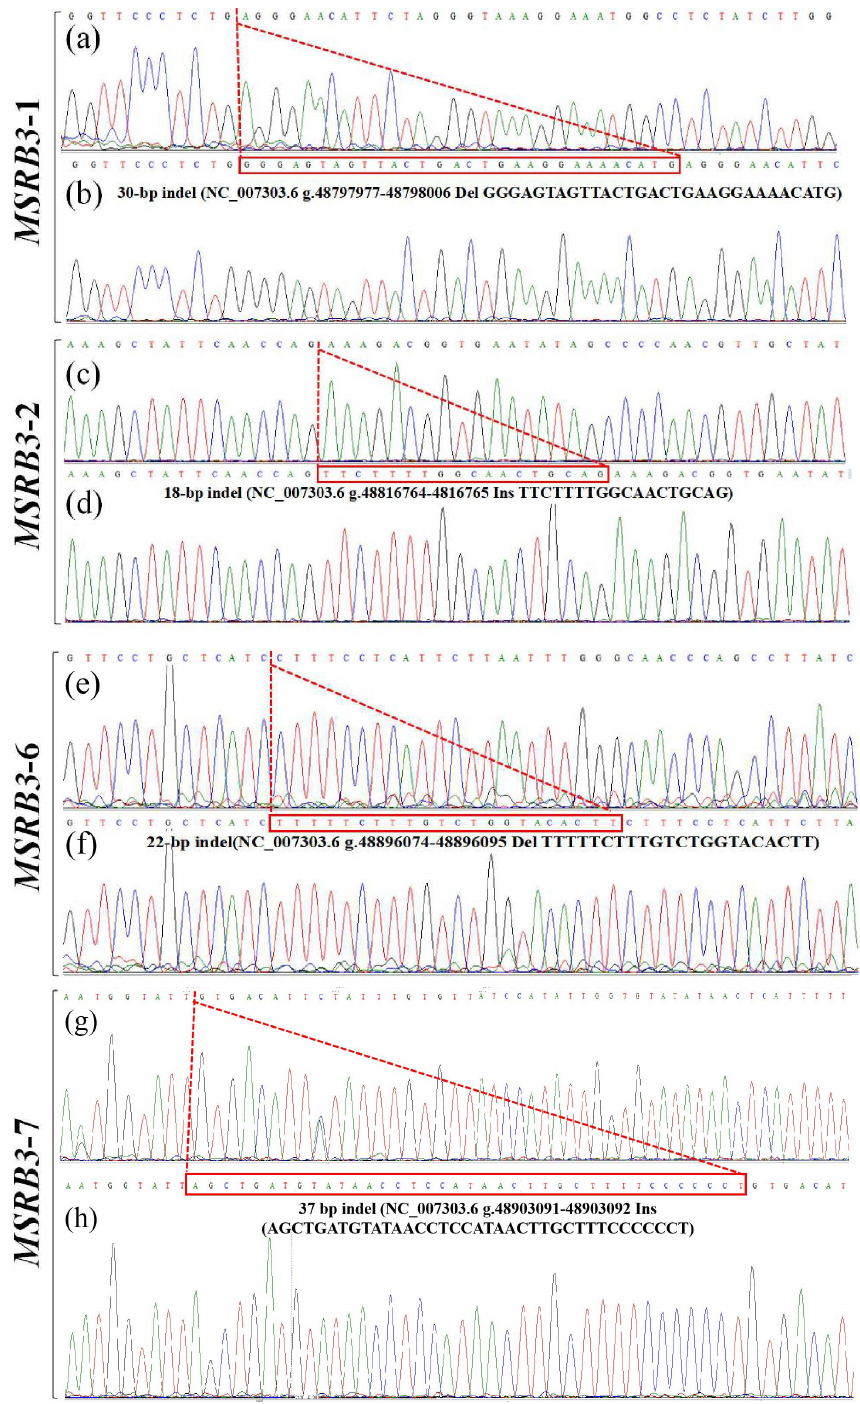
Figure 2. Sequencing maps of four indel loci in cattle MSRB3 gene. (a) Homozygotic deletion and deletion type (ID) of MSRB3 -1 locus; (b) homozygotic insertion and insertion type (II) of MSRB3 -1 locus, the sequence with a dashed red line boundary is a 30bp deletion; (c) homozygotic deletion and deletion type (ID) of MSRB3 -2 locus; (d) homozygotic insertion and insertion type (II) of MSRB3 -2 locus, the sequence with a dashed red line boundary is a 18bp insertion; (e) homozygotic deletion and deletion type (ID) of MSRB3 -6 locus; (f) homozygotic insertion and insertion type (II) of MSRB3 -6 locus, the sequence with a dashed red line boundary is a 22bp deletion; (g) homozygotic deletion and deletion type (ID) of MSRB3 -7 locus; (h) homozygotic insertion and insertion type (II) of MSRB3 -7 locus, the sequence with a dashed red line boundary is a 37bp